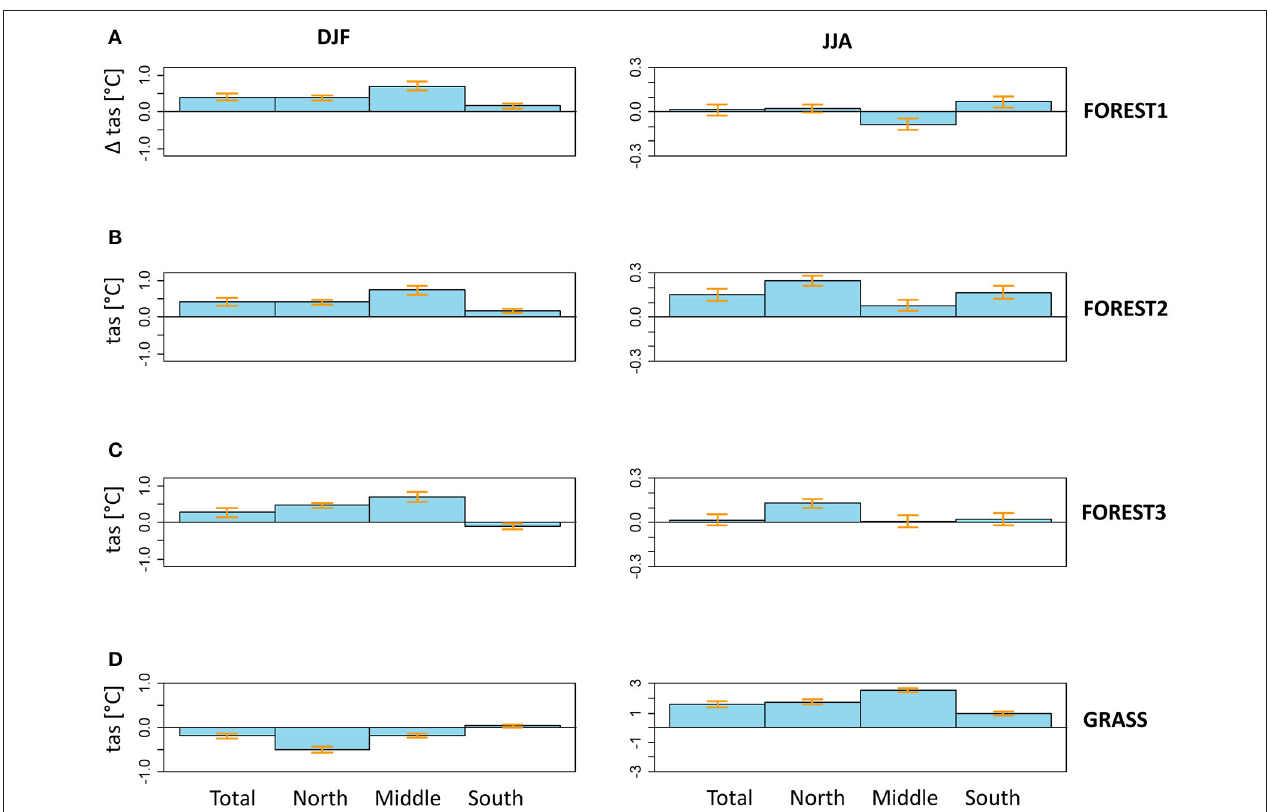
FIGURE 4 | Changes in mean near-surface air temperature compared to the EVALUATION simulation with no land cover change over the EURO-CORDEX domain of three afforestation experiments using a different albedo parameterizations [FOREST1 (A) , FOREST2 (B) , FOREST3 (C) ] and deforestation experiment [GRASS (D) ] for the whole of the domain (TOTAL), and with latitudinal separation in NORTH (58 ◦ -72 ◦ N) for high-latitudes, MIDDLE (43 ◦ -58 ◦ N) for mid-latitudes, SOUTH (30 ◦ -43 ◦ N) for the Mediterranean for winter (DJF) and summer (JJA) for 1986–2015. The errorbars represent ± two times the standard error around the mean. Plotted are differences over all land-points only. Note the different y-axis of GRASS in summer.